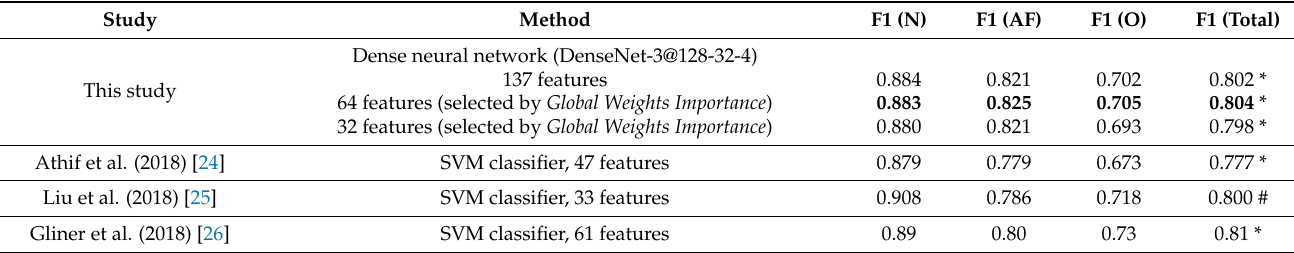
Table 7. Comparative performance evaluation of this study to other published studies based on the F1-score exactly as reported in the original articles. The selected studies are employing only hand-crafted ECG features and not raw ECG data representations that might add to the performance. A few details on the classification methods and number of features (where available) are